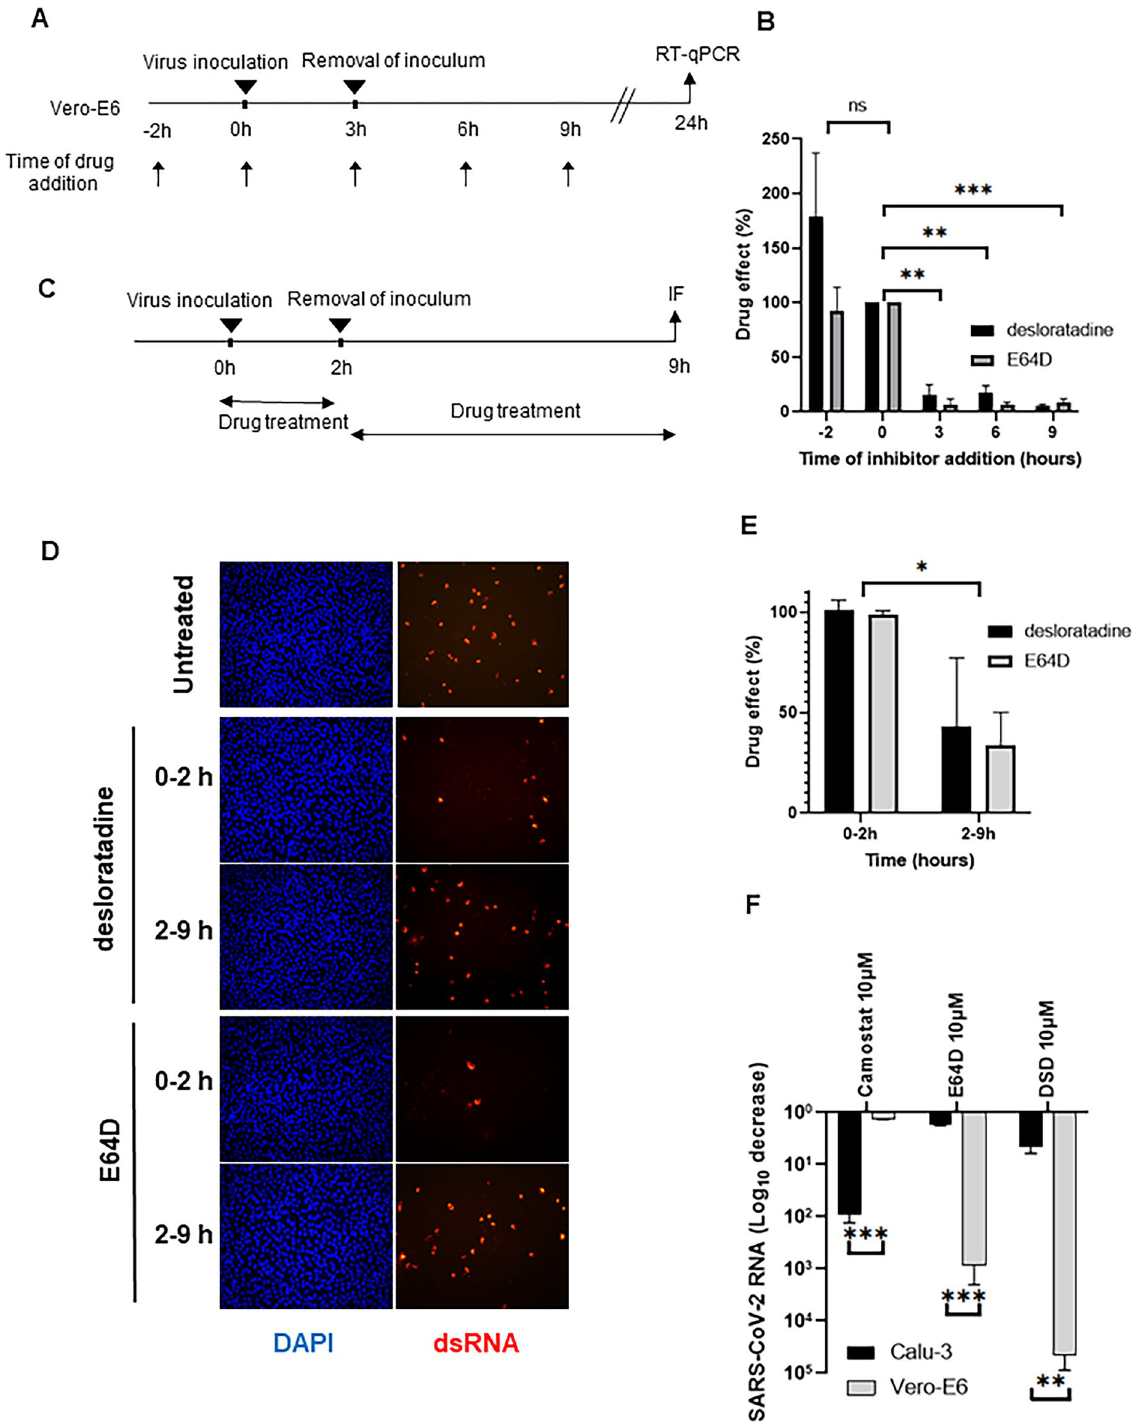
Figure 4. Desloratine inhibition of SARS-CoV-2 infection at an early step of the viral lifecycle. ( A ) Design of the time-of-drug addition assay in Vero-E6 cells. ( B ) Results of the time-of-drug addition assay using 10 µM of desloratadine (black bar) or 10 µM of E64D (grey bar), expressed as the percent effect of the drug at each time point relative to its effect when added at the time of infection, considered as 100%. ( C ) Design of the entry assay using desloratadine and E64D. 10 µM of the indicated drugs were added either during the first 2 h of infection or after removal of the inoculum between the 2nd and the 9th hours. ( D ) Cells infected at different time points studied by immunofluorescence using an antibody directed against double-stranded RNA (dsRNA). ( E ) Quantification of immunofluorescence in cells infected at different time points. The percent effect of 10 µM of desloratadine (black bars) and 10 µM of E64D (grey bars) is shown relative to its effect when the drugs were added between 0 and 2 h, considered as 100%. ( F ) Effect of 10 µM of desloratadine, camostat and E64D on SARS-CoV-2 RNA production in Vero-E6 (grey bars) and TMPRSS2-expressing Calu-3 cells (black bars), as assessed by